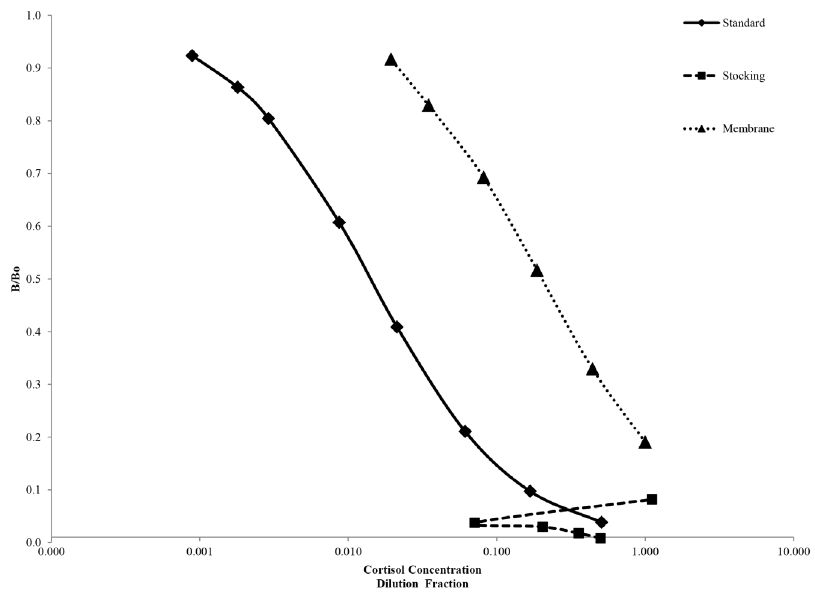
Figure 2. A representative dilution series showing parallelism between cortisol standard with blow samples recovered from nylon stocking and nitex membrane. Nitex membrane shows good parallelism while nylon stocking displays a deviated